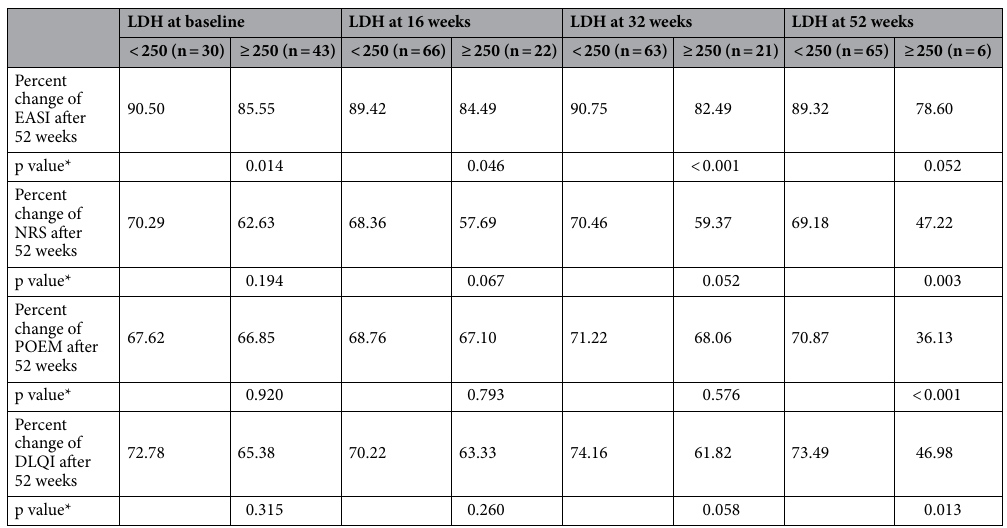
LDH at baseline LDH at 16 weeks LDH at 32